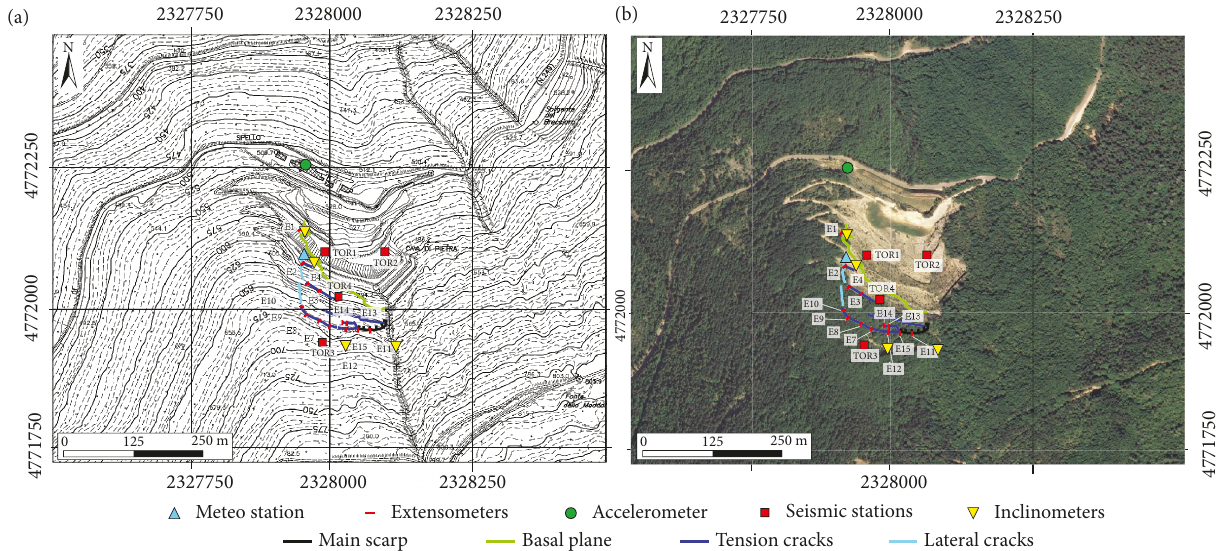
Figure 2: (a) Regional Topographic Map and (b) satellite view of the “traditional” monitoring network and the passive seismic array installed to monitor the Torgiovannetto quarry. Red squares representthe seismic stations, the light blue triangle represents the meteorological station, red lines represent the extensometers, and yellow triangles represent the inclinometers. The main scarp (black line), the basal plane (green line), and the tension and lateral cracks (dark blue and light blue, respectively) were detected by